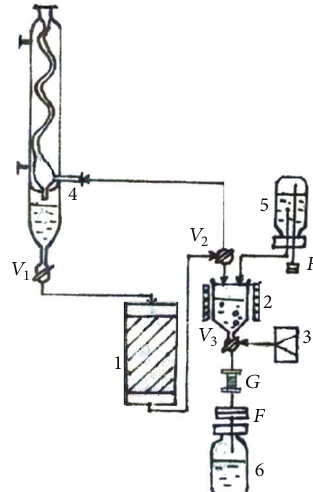
Figure 18: Process diagram of the solid-liquid extraction-based 99 m Tc-generator system GELUTEC-B developed in NRI. 1: 99 Mo- loaded molybdate-gel column; 2: acetone evaporator; 3: air pump; 4: acetone reservoir/condenser; 5: saline for recovery of 99 m Tc- pertechnetate; 6: 99 m Tc-pertechnetate injectable solution; 𝑉 1 valves; G: alumina guard column; MF: Millipore filter [57, 59, 60, 103, 105,